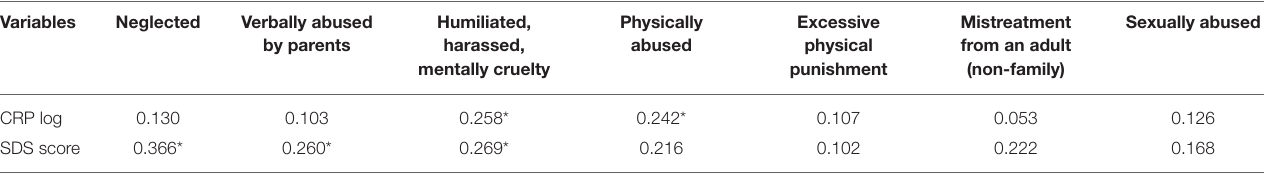
TABLE 3 | Pearson correlations between CRP and child-direct childhood stressors.